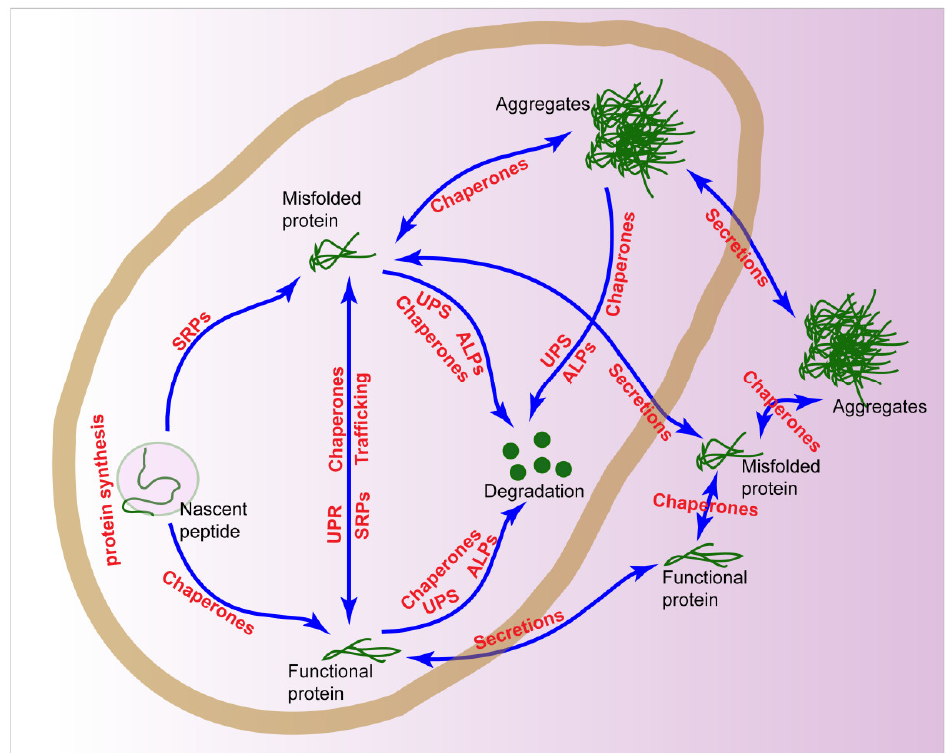
Figure 1. Proteostasis networks (PNs) in the cells. The proteostasis in a cell is regulated by protein synthesis, chaperones, unfolded protein responses (UPRs), stress response pathway (SRPs), ubiquitin proteasome system (UPS), autophagy-lysosomal pathways (ALPs), and secretions.